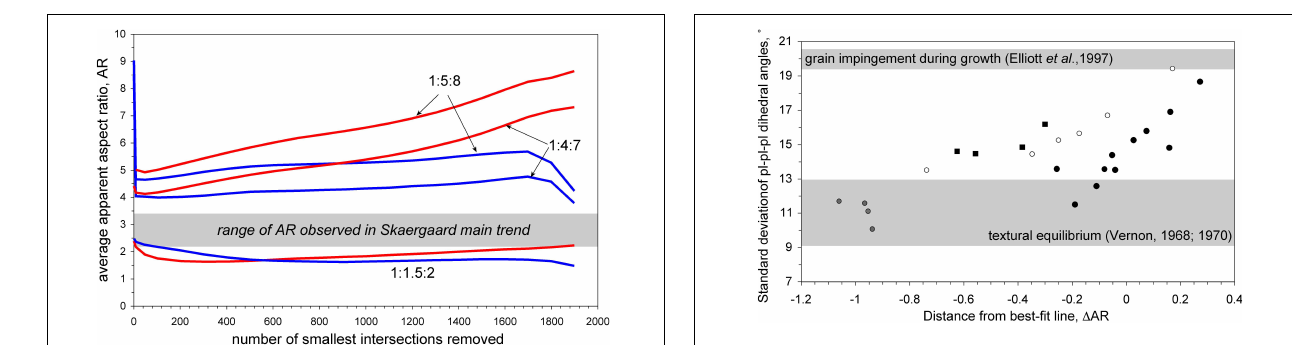
FIGURE 7 | The variation of average apparent aspect ratio (AR) for synthetic rocks comprising grains of constant shape (either 1:1.5:2, 1:4:7, or 1:5:8) as a function of the completeness of the population of grain intersections. The shape of a total of 2,000 intersections was calculated, and AR was calculated by omitting progressively more of the smallest intersections. For each of the three shapes, the red line shows the variation of AR in a perfectly foliated system while the blue line shows that for entirely randomly oriented grains. The horizontal gray box shows the range of AR found in the main group of Skaergaard troctolites (shown in Figure 5 ).